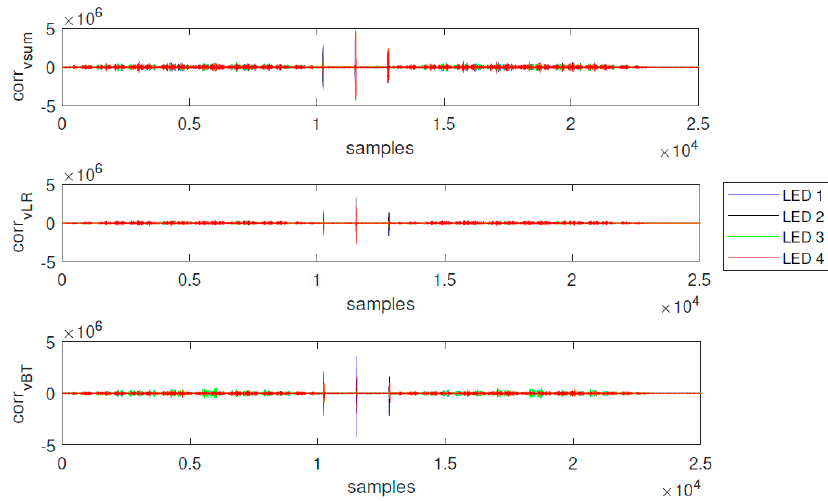
Figure 9. Correlation functions of the three acquired signals v fsum , v fLR and v fBT , with each one of the transmitted codes.